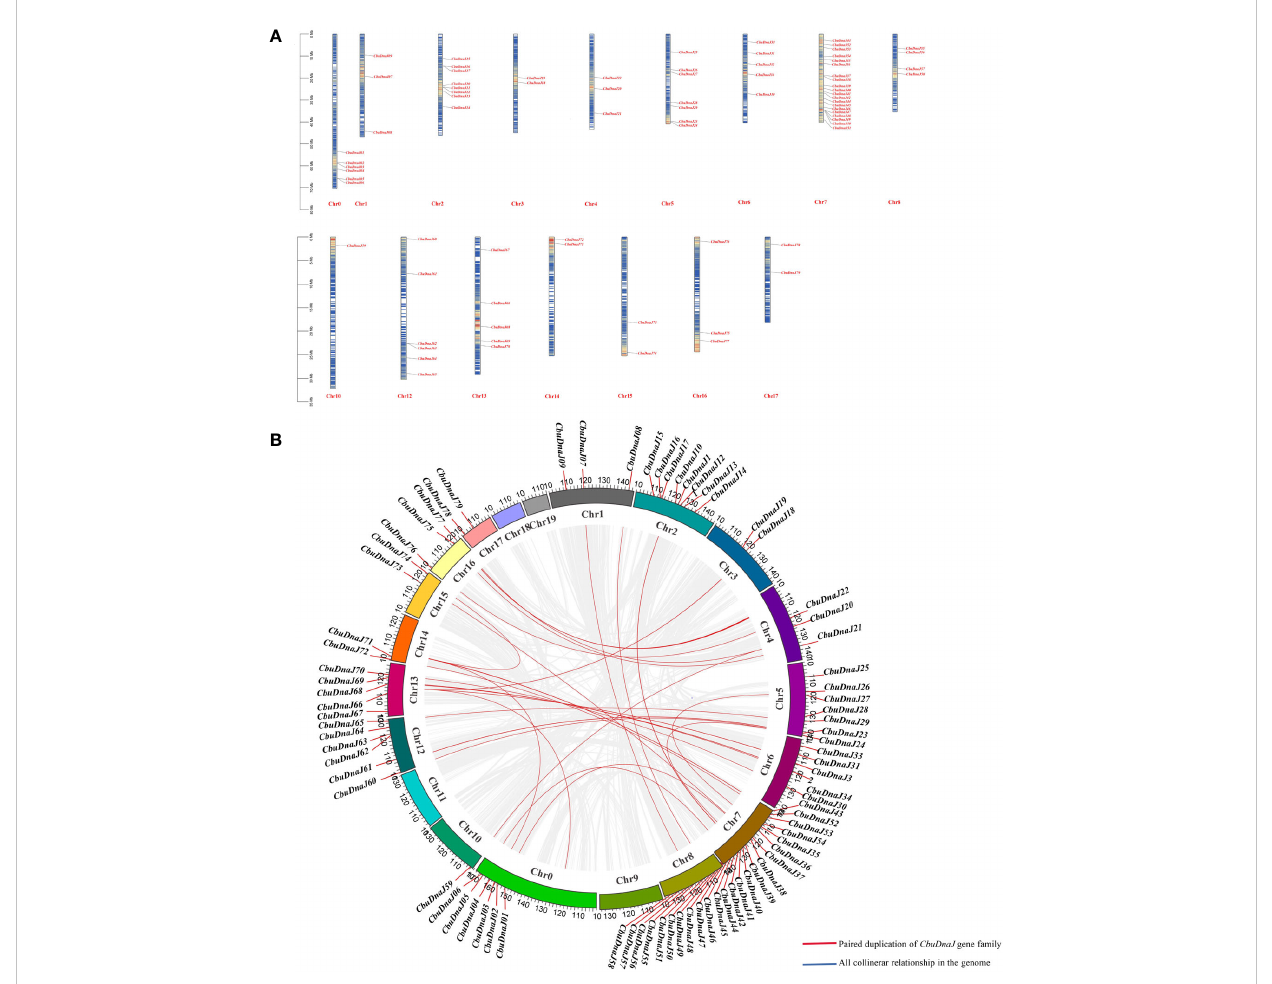
FIGURE 3 The chromosomal distribution of CbuDnaJ genes duplication events. (A) Chromosomal distribution of the CbuDnaJ genes. The chromosome numbers are indicated at the top end of the chromosome. The different colors in chromosomes represent gene density. The scale on the left is in million bases (Mb). (B) Collinearity of replicative genes in the protein family. The scale on the circle is in million bases (Mb). Gene IDs on the chromosomes indicate the positions of